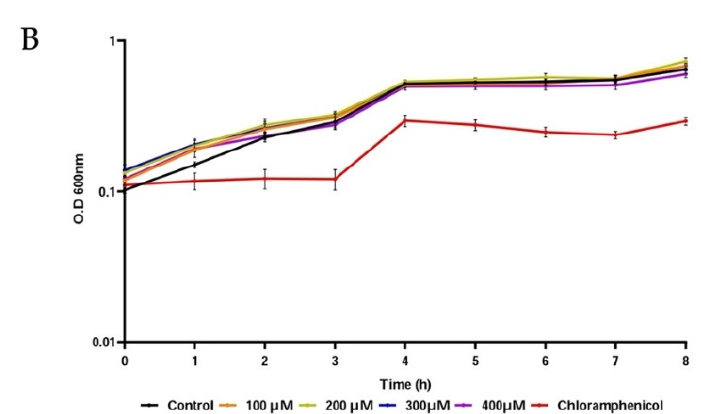
Figure 7. Anti-quorum-sensing activity of P 5 W 30 at concentrations 100 µ M (0.83 mg · mL − 1 ), 200 µ M (1.65 mg · mL − 1 ), 300 µ M (2.48 mg · mL − 1 ), and 400 µ M (3.31 mg · mL − 1 ). ( A ) Effect of P 5 W 30 on violacein production (OD 585nm ). ( B ) Effect of P 5 W 30 on C. violaceum CV026 growth. Error bars represent standard deviation ( n = 3). **** p < 0.0001, ns—not